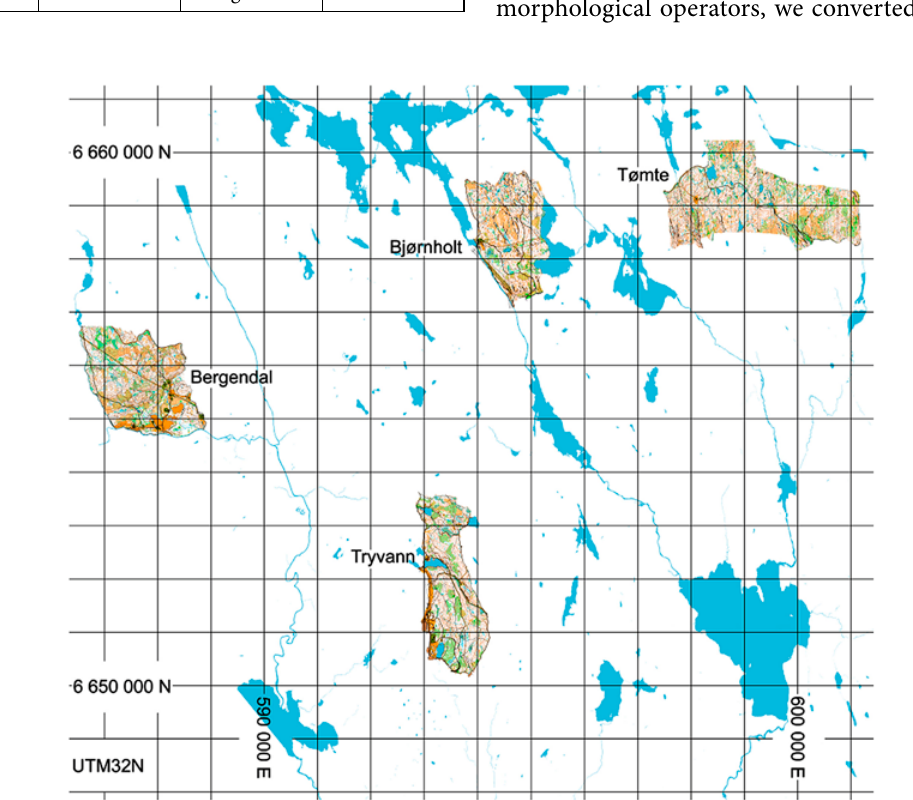
Fig. 2. Location of areas surveyed in 2013. The grid lines are 1 km apart and the coordinates are in meters in UTM zone 32 N, datum =